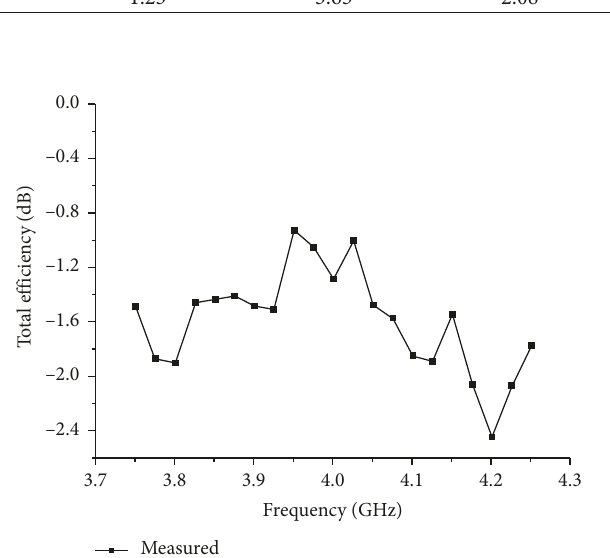
Figure 9: Measured total efficiency in free-space of the proposed cavity-backed prototype antenna.